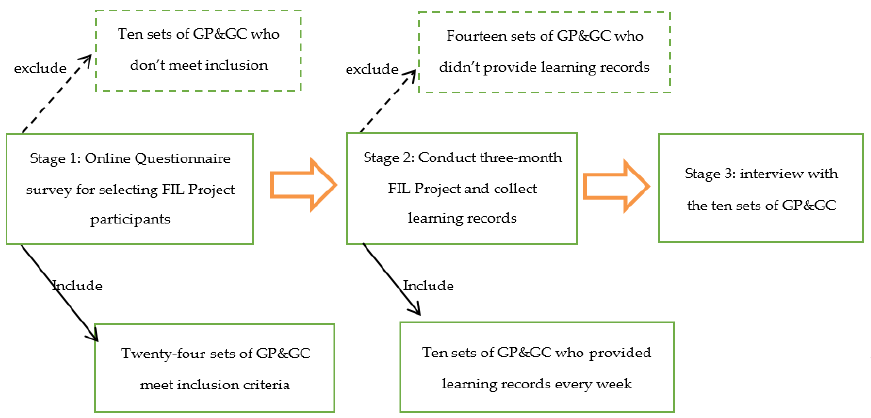
Figure 1. Research process and sampling stages.